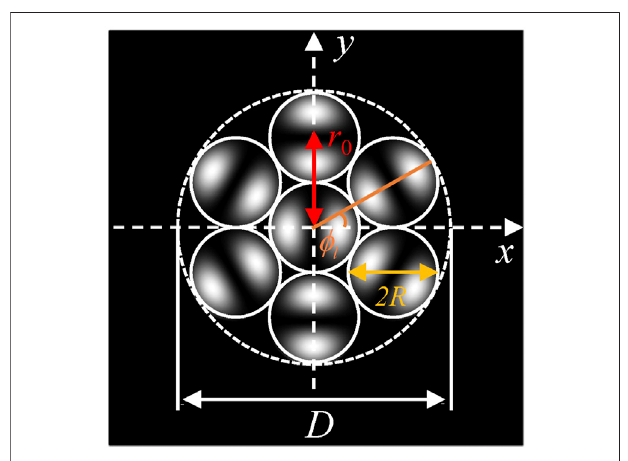
FIGURE 1 | Schematic diagram of a HOM beam